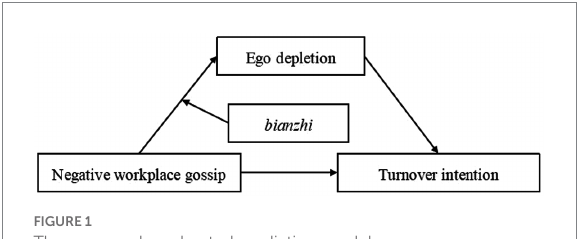
FIGURE 1 The proposed moderated mediation